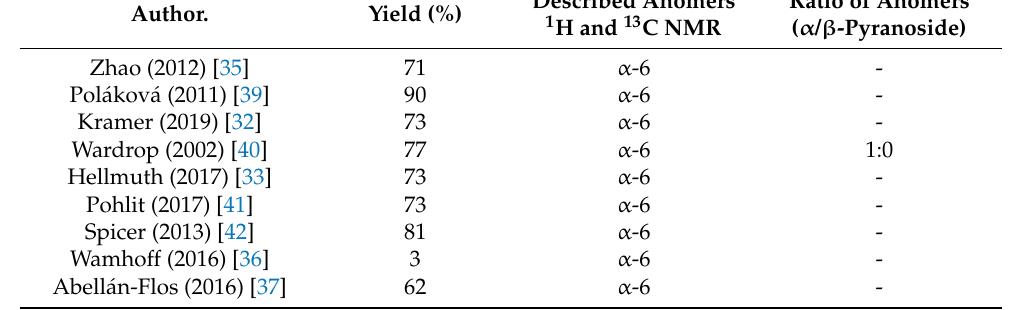
Table 3. Overview of preparations where propargylation of per- O -acetylated mannose was performed. Author.